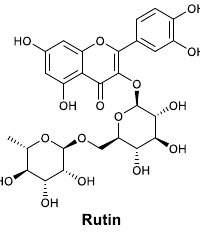
Figure 12. Structures of icariin and rutin.